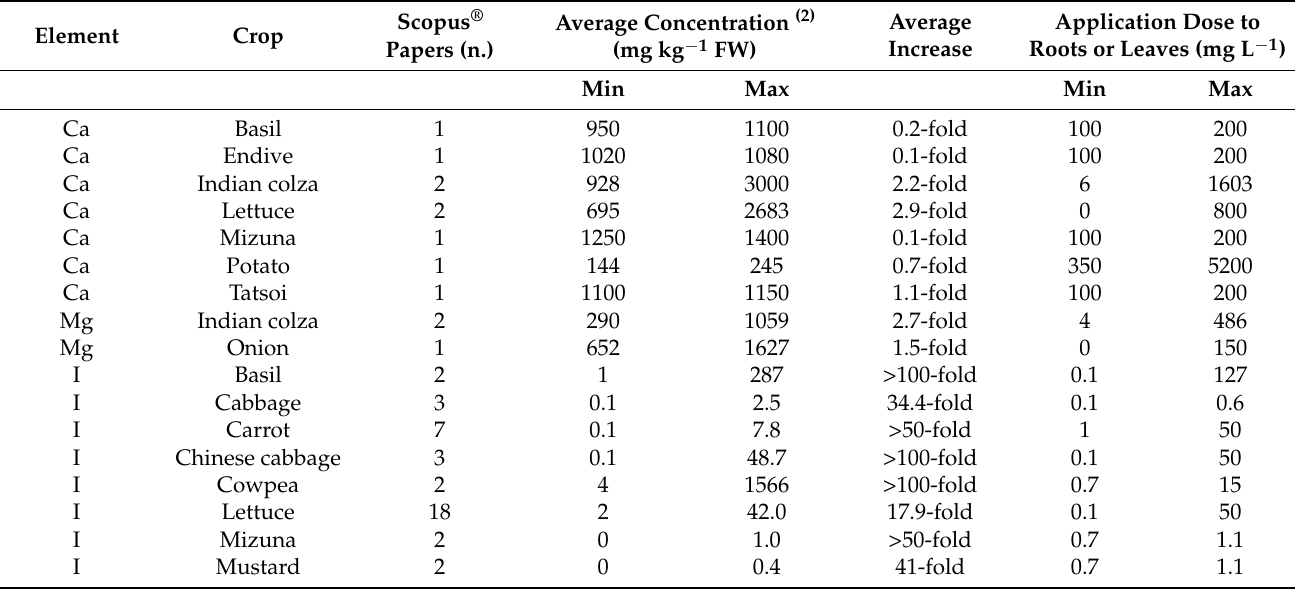
Table 1. Response of some vegetable crops to biofortification (1)